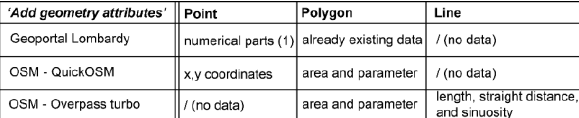
Table 1. Built-in tool ‘Add geometry attributes’ tested on collected material gave different results. “No data” represents that the initial material did not contain those values (source: